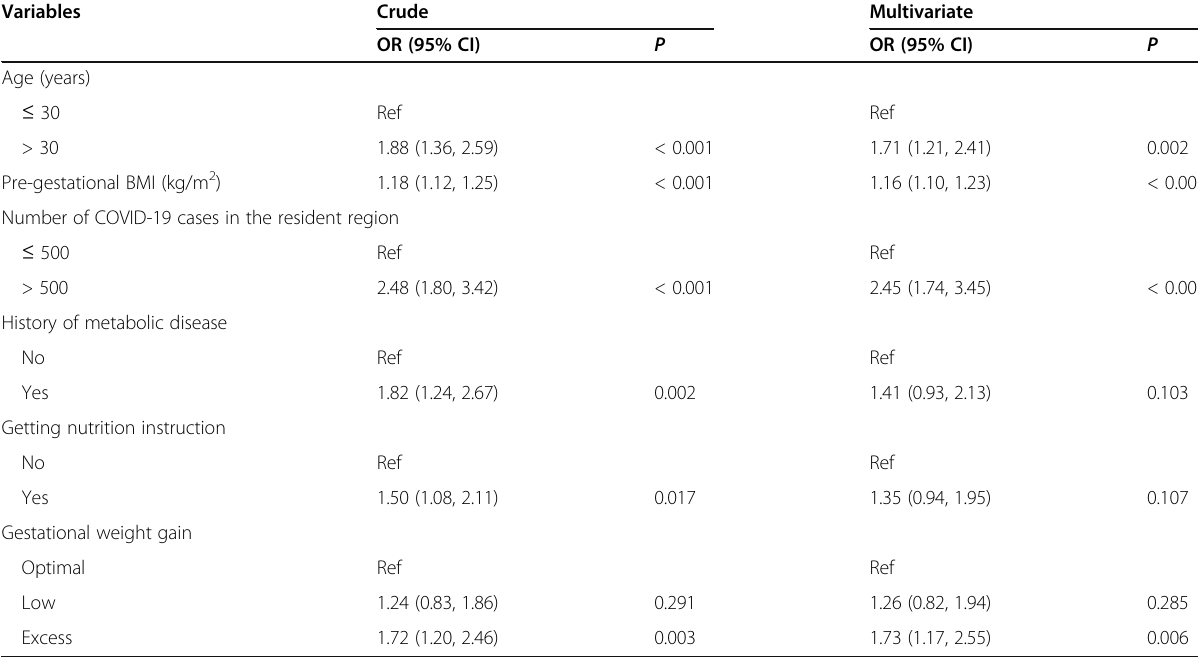
Table 3 Multivariate analysis of associated factors of delivery mode